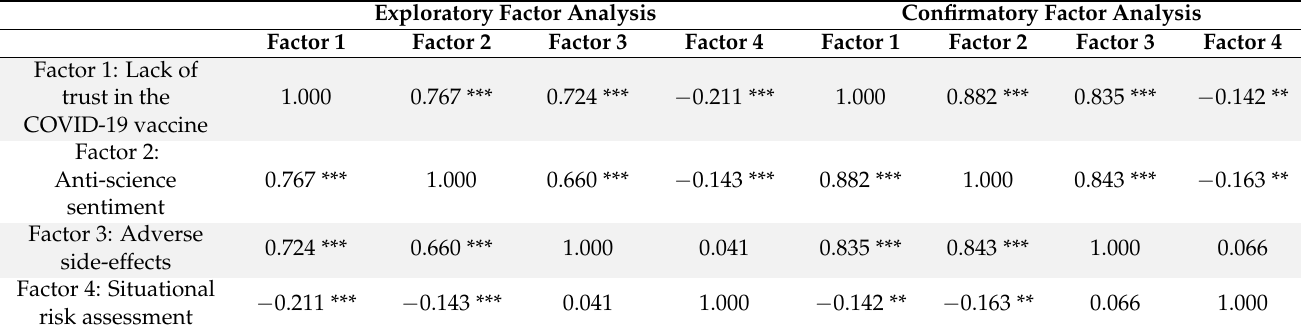
Table A1. Correlation Matrix of